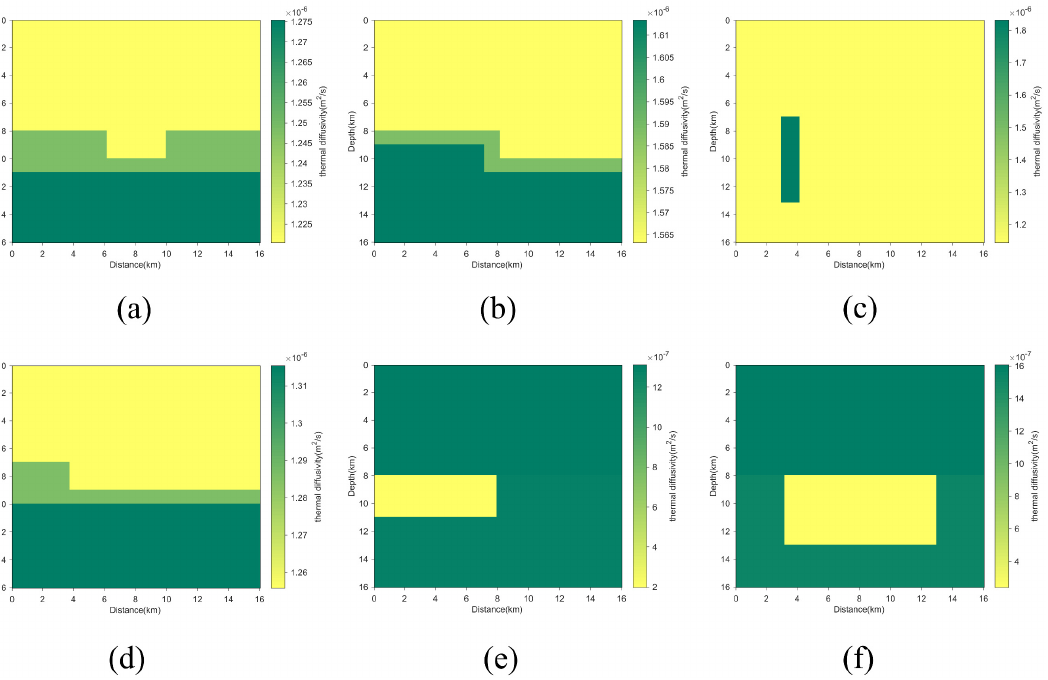
Figure 7. The temperature field labels of six geological models ( a – f ) from the training data set. ( a ) Temperature field of Graben model, ( b ) temperature field of pleated − structure model, ( c ) tempera- ture field of magmatic intrusion model, ( d ) temperature field of platform model, ( e ) temperature field of magmatic intrusion model, ( f ) temperature field of magmatic intrusion model. The finite element method was used to simulate the heat conduction of the model, the temperature field after 100,000 years was simulated, and the label was established. Data preprocessing was used to reduce the influence of the numerical difference be- tween the parameters of the model and decrease the fitting time of the HDRT − UNet. We used the normalization method to preprocess the formation parameters. The purpose of normalization is to process the data of different scales and dimensions, so that they can be